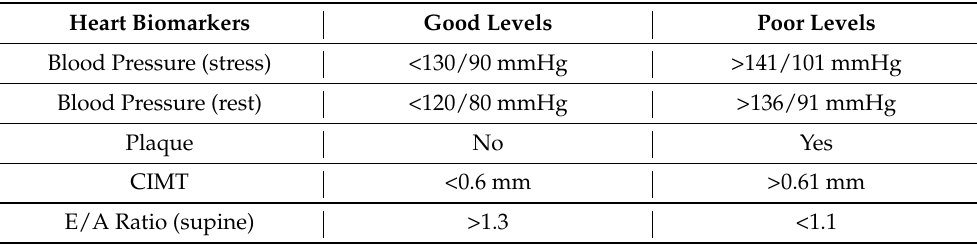
Table 1. Good vs. Poor Levels for the heart biomarkers used in the study, with ranges following the protocols of the Boone Heart Institute.